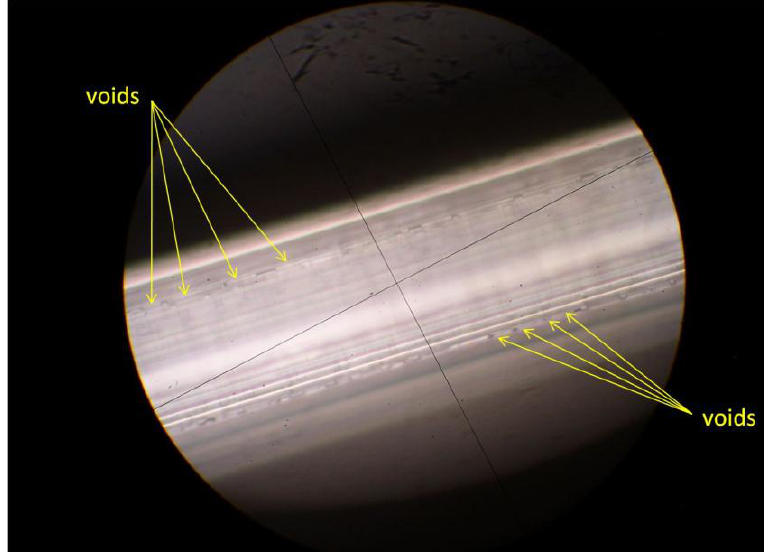
Figure 3. View of anthracene fibers in MOF at 500× showing voids along growth direction. Anthracene fibers grown without voids are translucent and not visible using incandescent